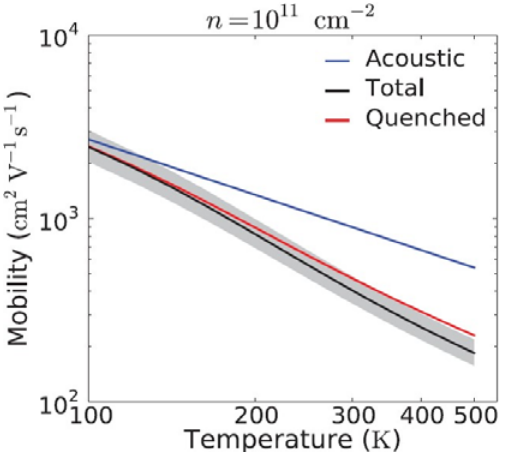
Figure 4. The temperature dependence of the mobility at carrier density n = 10 11 cm − 2 calculated with the full collision integral. For comparison, the mobility in the presence of only acoustic deformation potential scattering with the temperature dependence is shown by blue line. The (gray) shaded area shows the variation in the mobility associated with a 10% uncertainty in the calculated deformation potentials. Reproduced with permission from [120], American Physical Society, 2012.